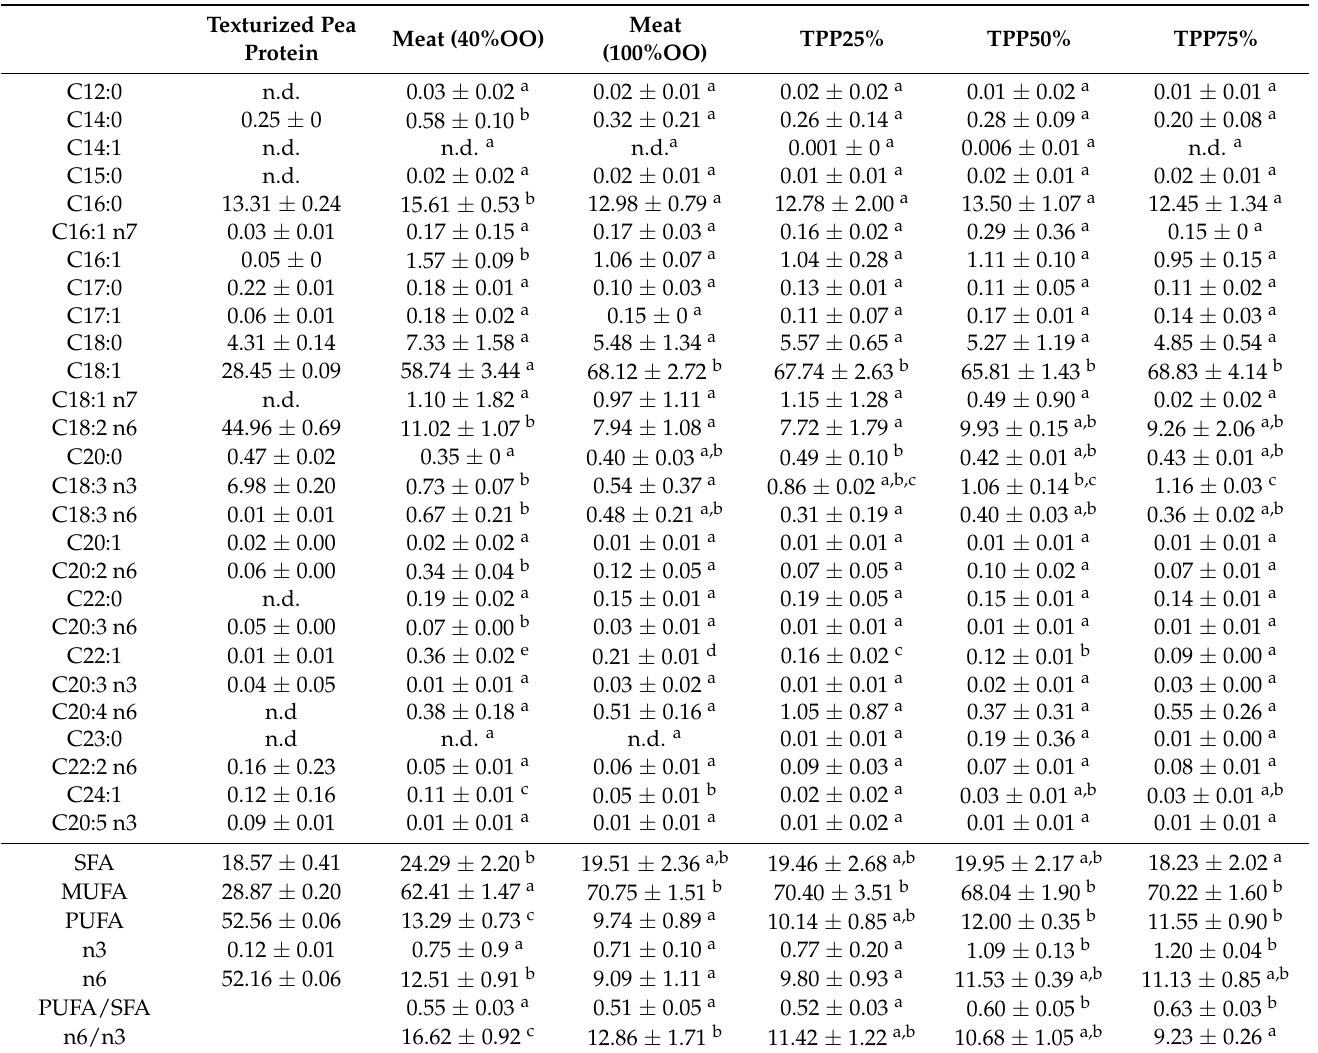
Table 5. Mean values (+SD) of fatty acid composition for all frankfurter